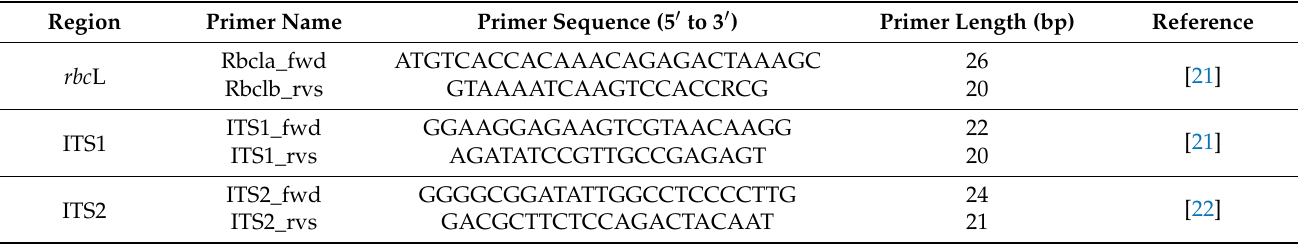
Table 1. Polymerase Chain Reaction (PCR) profiles used in this study.